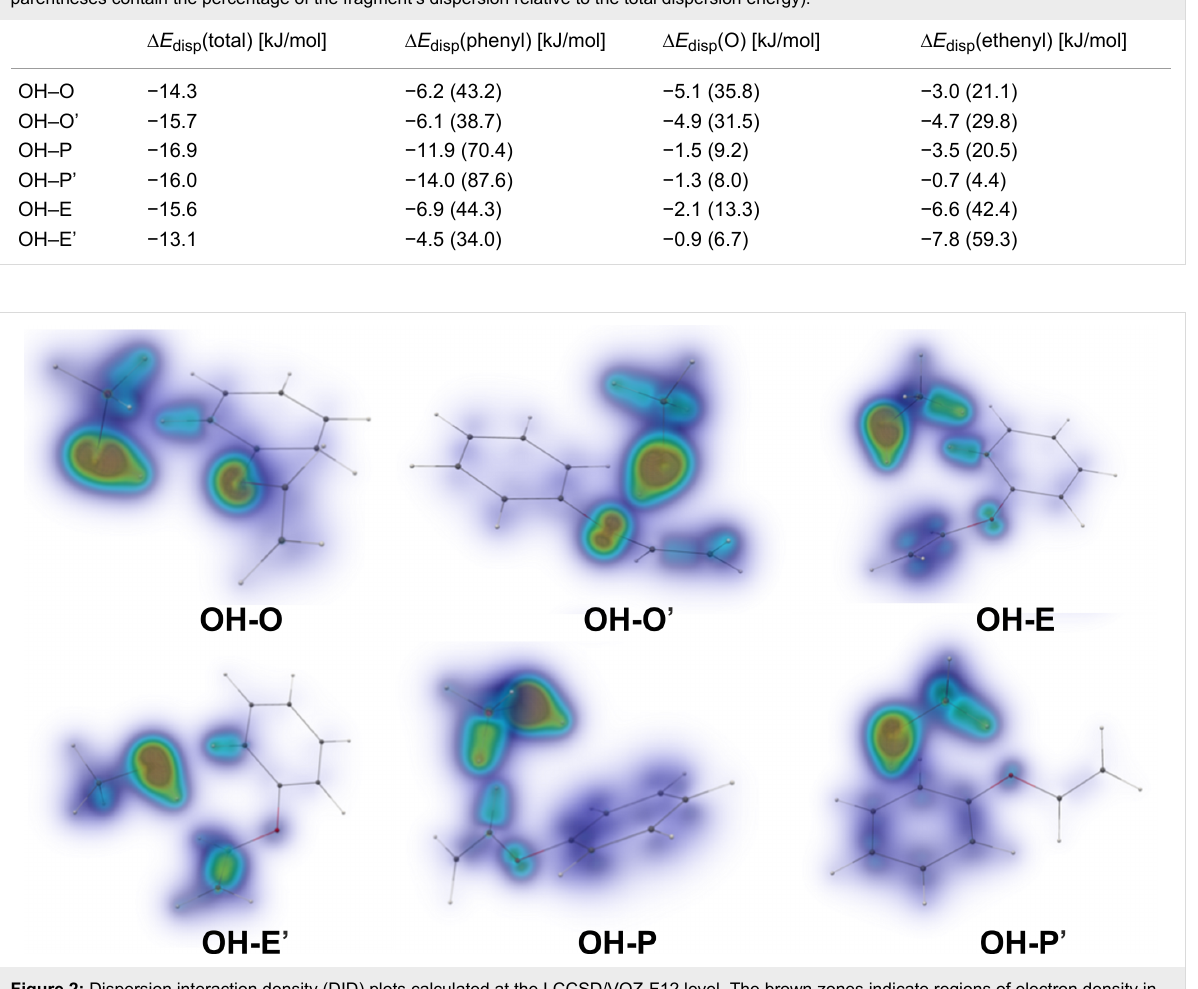
Table 2: Comparison of different structures for PVE–MeOH dimers, with dispersion energies calculated at the LCCSD/VQZ-F12 level of theory (the parentheses contain the percentage of the fragment’s dispersion relative to the total dispersion energy).